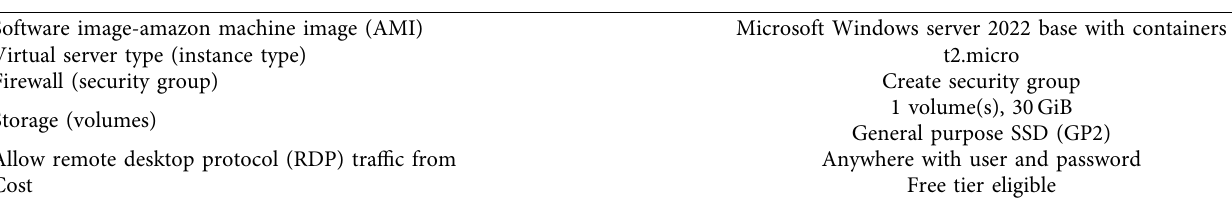
Figure 8: SIH architecture [32]. Table 2: EC2 server